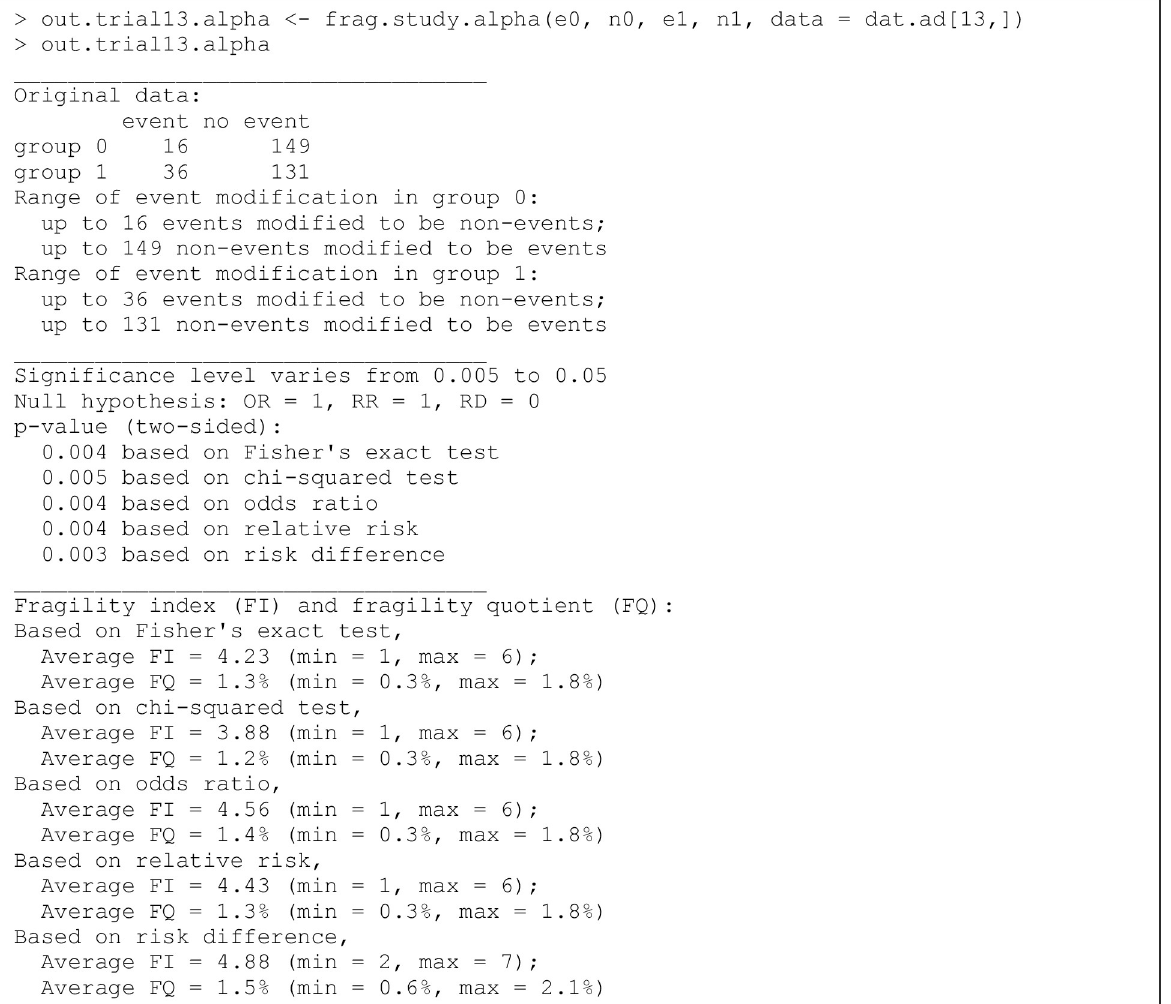
Fig 7. Output from the function frag.study.alpha()